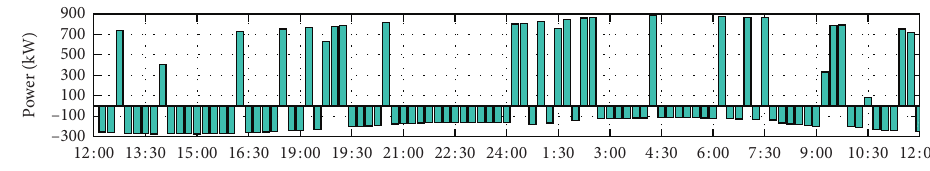
Figure 20: Output power of virtual energy storage with independent participation of air conditioning in